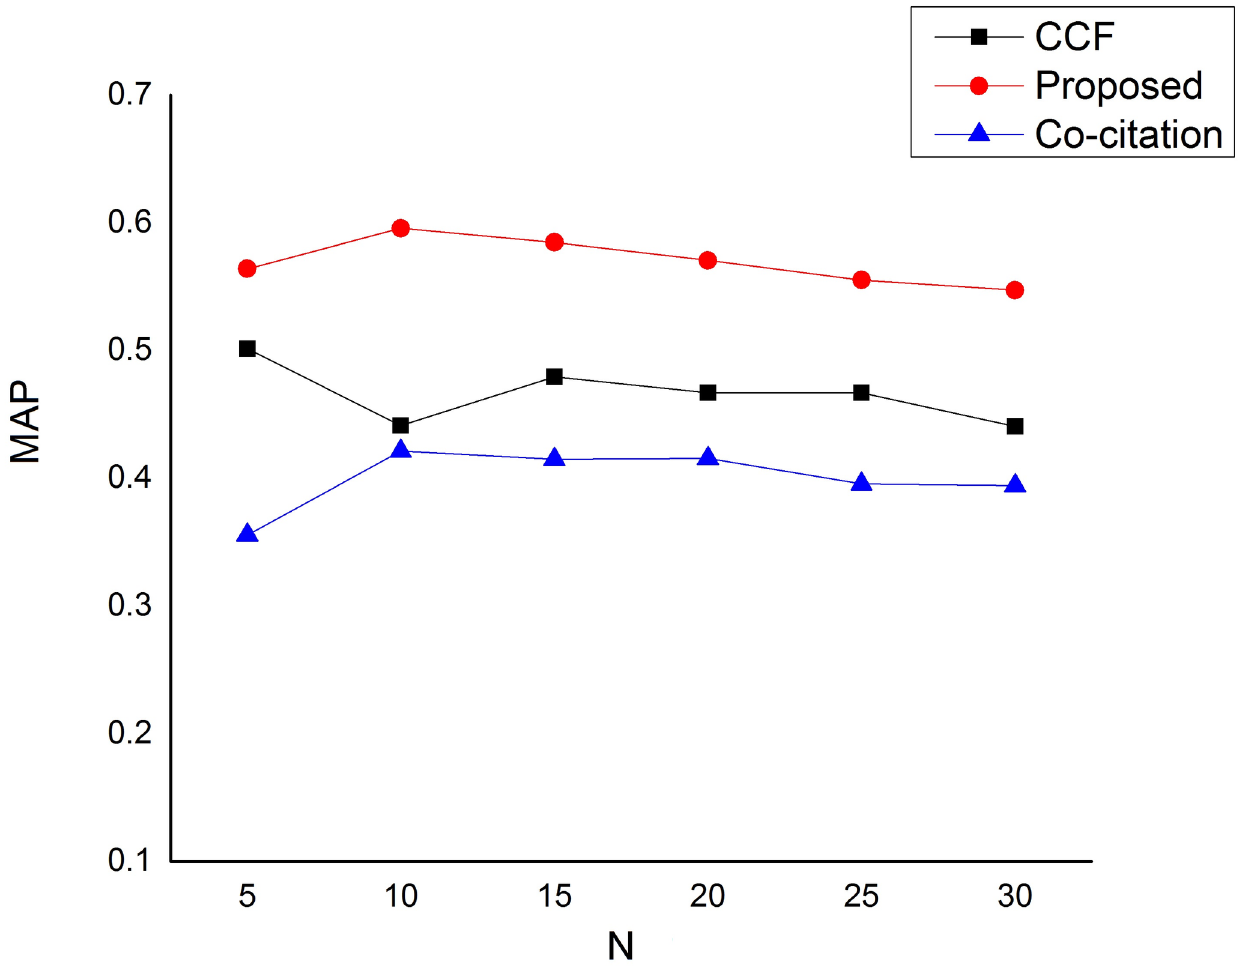
Fig 5. Mean AveragePrecision (MAP) performance on the dataset.